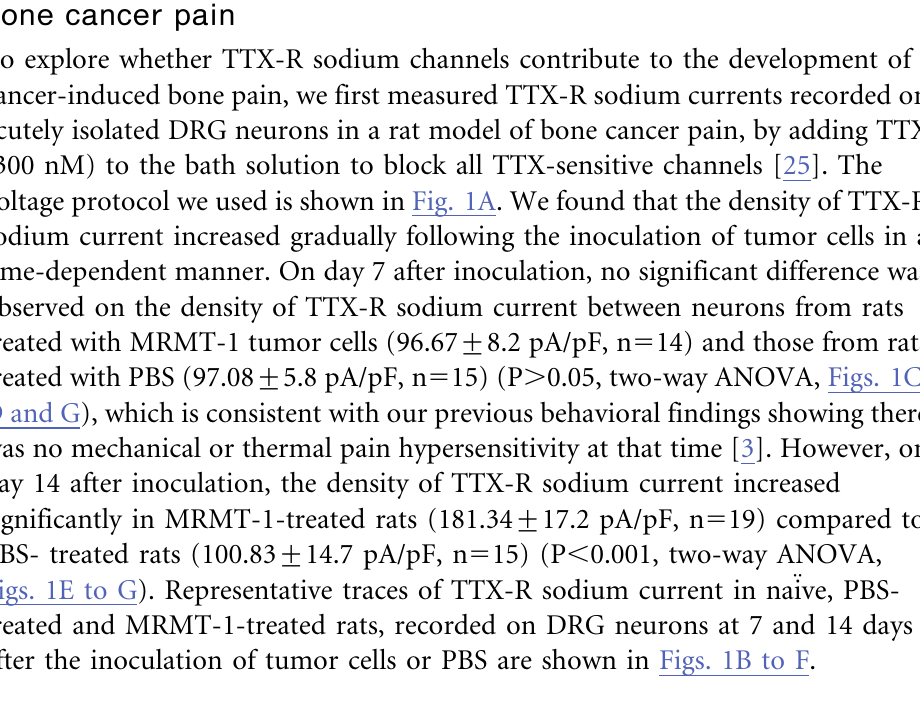
Figs. 1E to G). Representative traces of TTX-R sodium current in nai¨ ve, PBS- treated and MRMT-1-treated rats, recorded on DRG neurons at 7 and 14 days after the inoculation of tumor cells or PBS are shown in Figs. 1B to